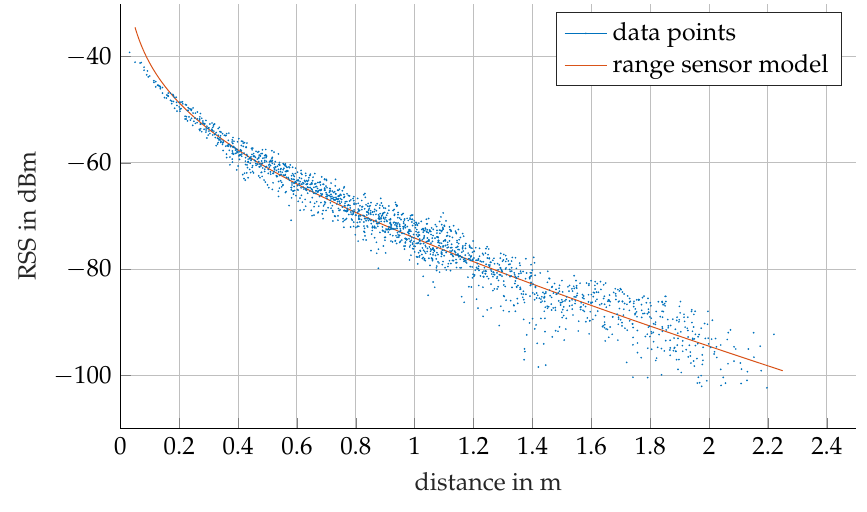
Figure 16. Underwater range sensor model and RSS